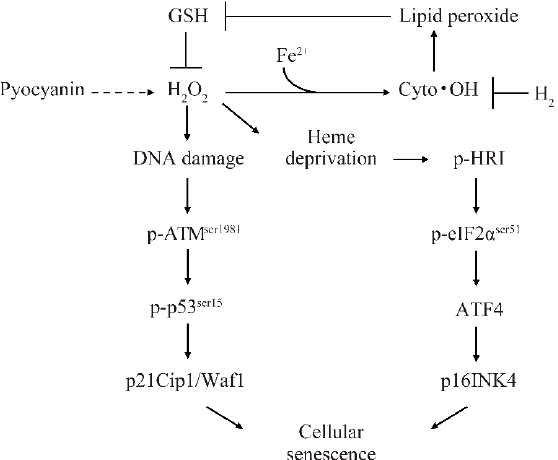
Figure 5. Schematic diagram of cyto • OH-induced cellular senescence model. The solid arrows indicate direct induction, the dotted arrows indicate indirect induction, and the “T” arrows indicate inhibition.